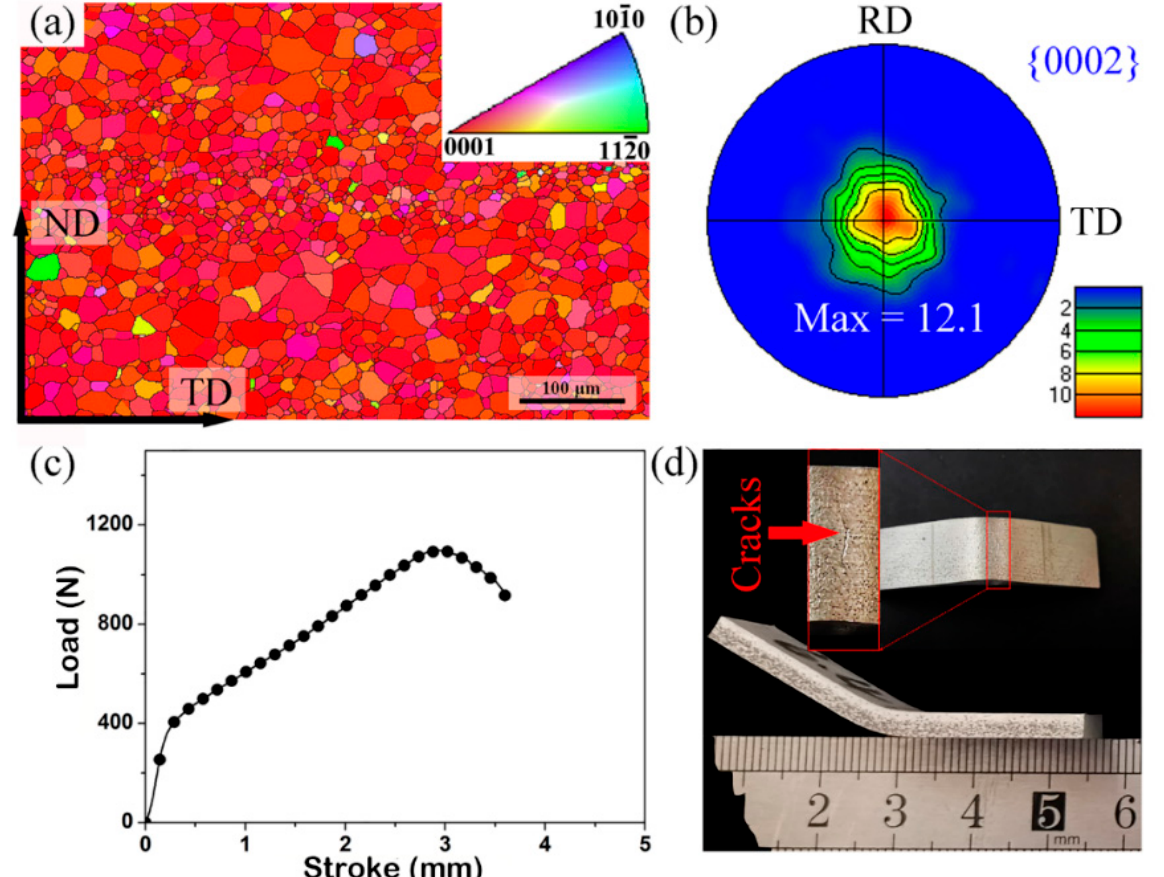
Figure 2. Results of EBSD measurement and bending experiment: ( a ) IPF coloring map, ( b ) (0002) pole figure of the as-rolled AZ31 alloys sheet, ( c ) bending load-stroke curve and ( d ) images of the bent sample.